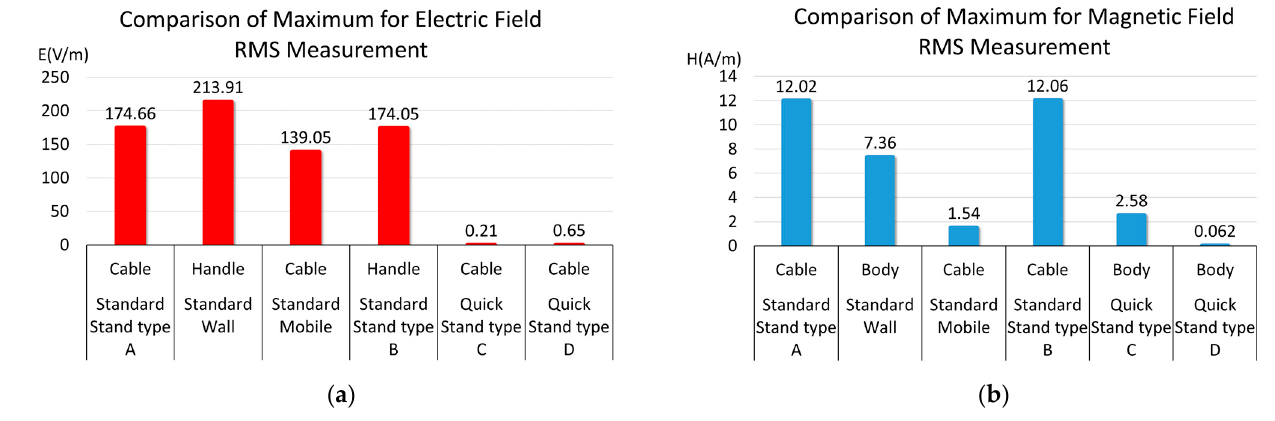
Figure 5. Comparison of maximum RMS measurement value: ( a ) electric field RMS measurement; ( b ) magnetic field RMS measurement.